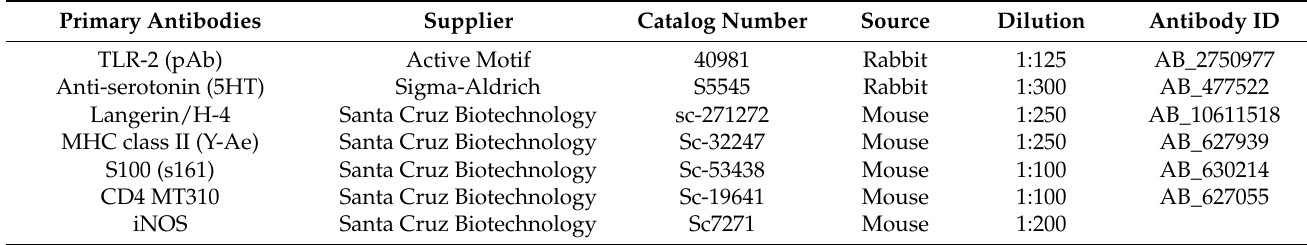
Table 2. Antibodies